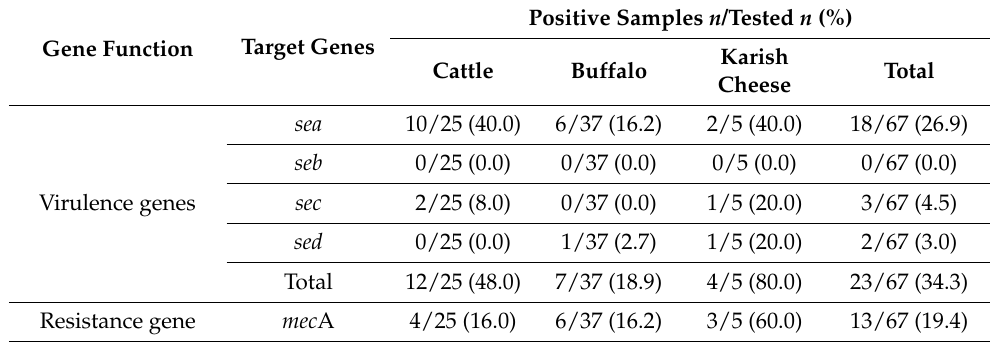
Table 3. Occurrence and distribution of enterotoxin and mec A gene among different sources.